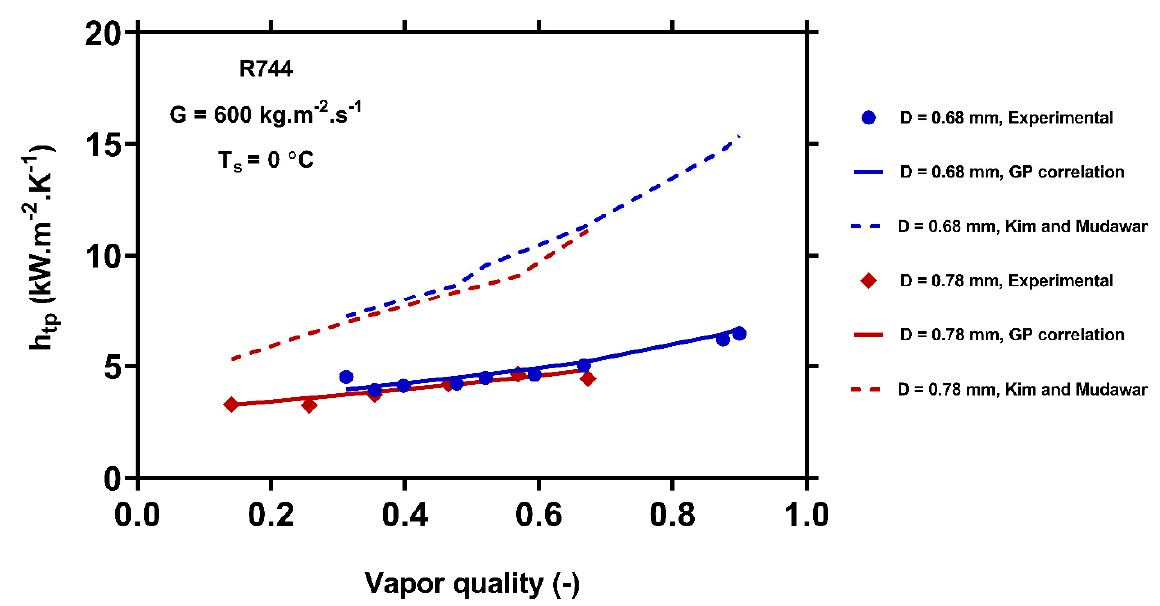
Figure 6. Comparisons of the predictions of the GP correlation (Equation (13)) and the model of Kim and Mudawar [52] with the experimental data [82] for R744 condensing at the mass flux of 800 kg · m − 2 · s − 1 and saturation temperature of 0 ◦ C inside different channel diameters. Blue and red points represent the D = 68 mm and D = 78 mm, respectively. The solid points, solid lines, and dash lines represent the experimental values, GP outcomes and Kim and Mudawar [52]